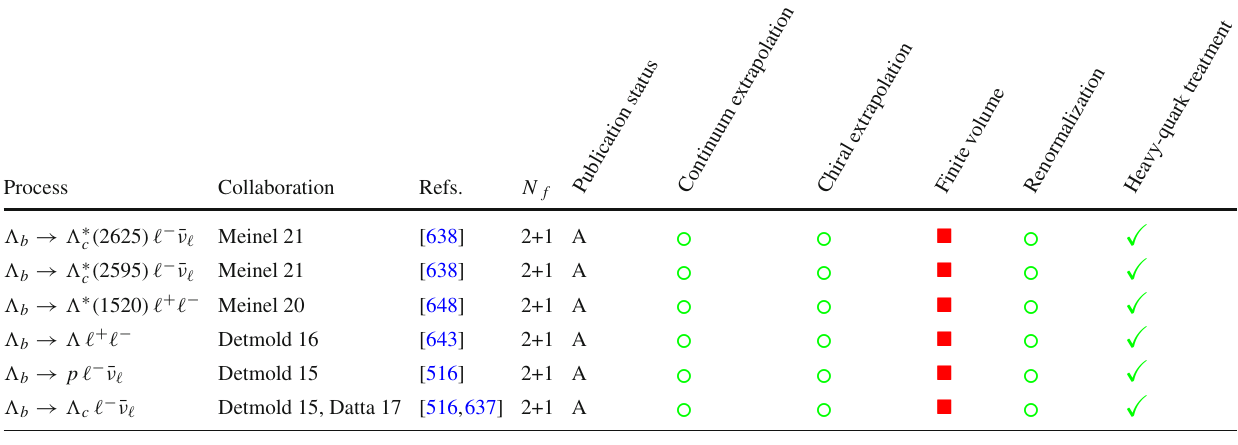
Table 56 Experimental measurements for B ( B − → τ − ¯ ν) . The first error on each result is statistical, while the second error is systematic